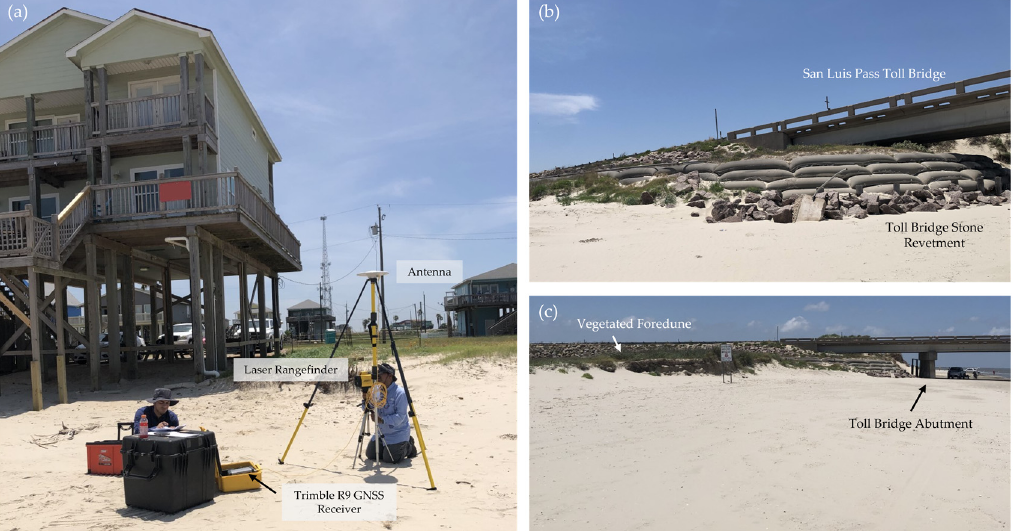
Figure 2. Survey set-up for Follett’s Site 1 in May of 2022. ( a ) GPS base station setup with a rangefinder used to collect distances between the base station and the ground control points; ( b ) San Luis Toll bridge with sandbags and partial stone revetment; ( c ) Vegetated dune field within the survey site in relation to the toll bridge.